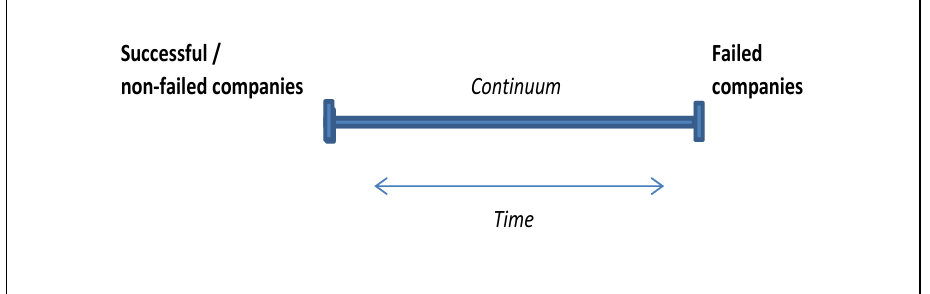
FIGURE 1: Financial distress continuum Source: Adapted from Cybinski